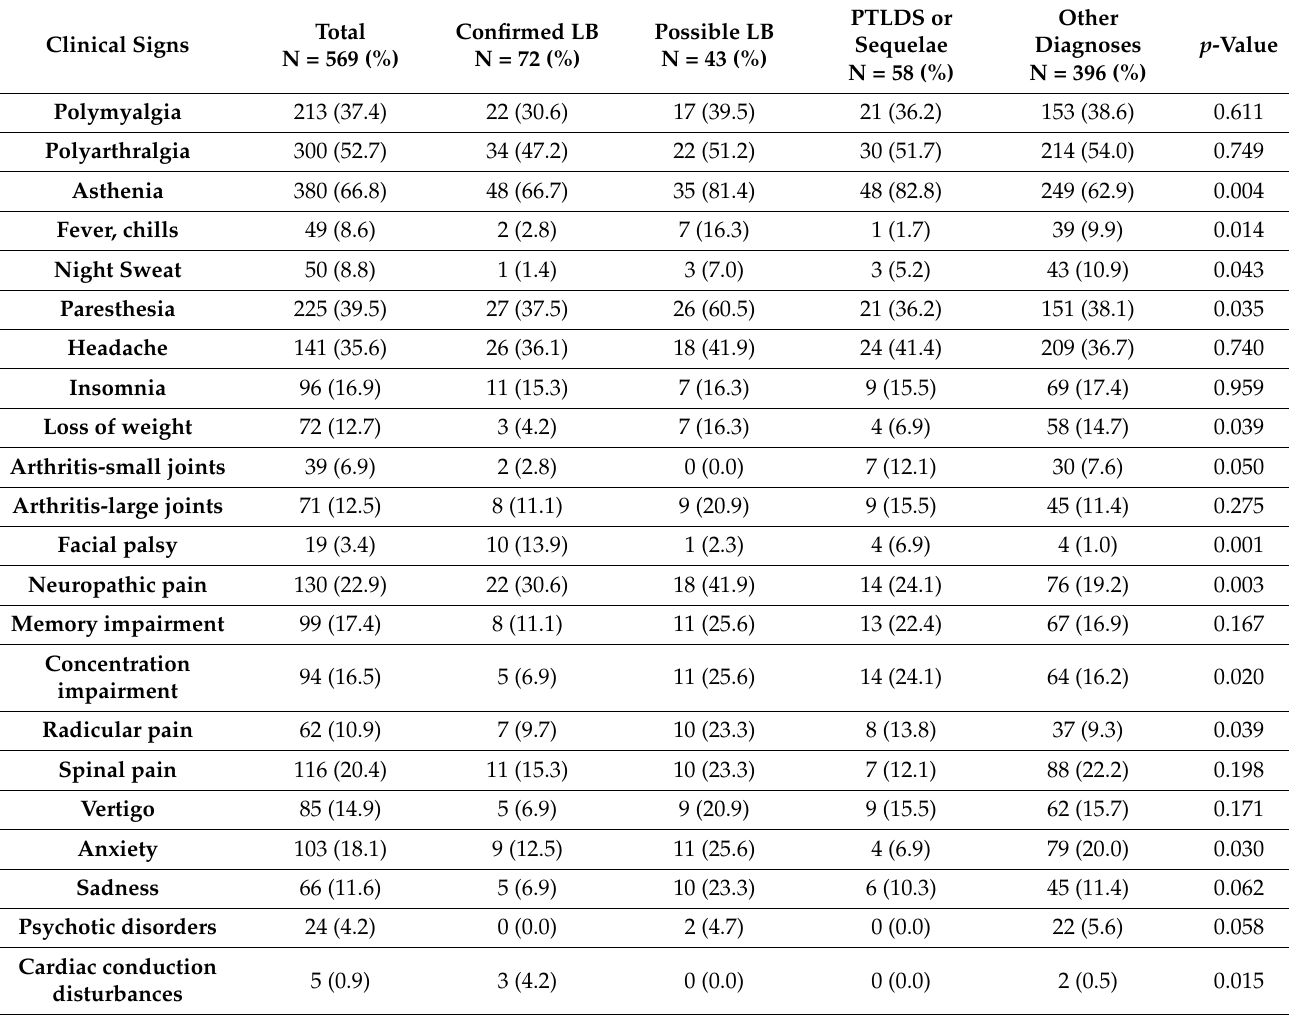
Table 4. Comparison of the main clinical signs and symptoms presented by the patients consulting at TBD-RC of Paris and Northern region at baseline in the four different